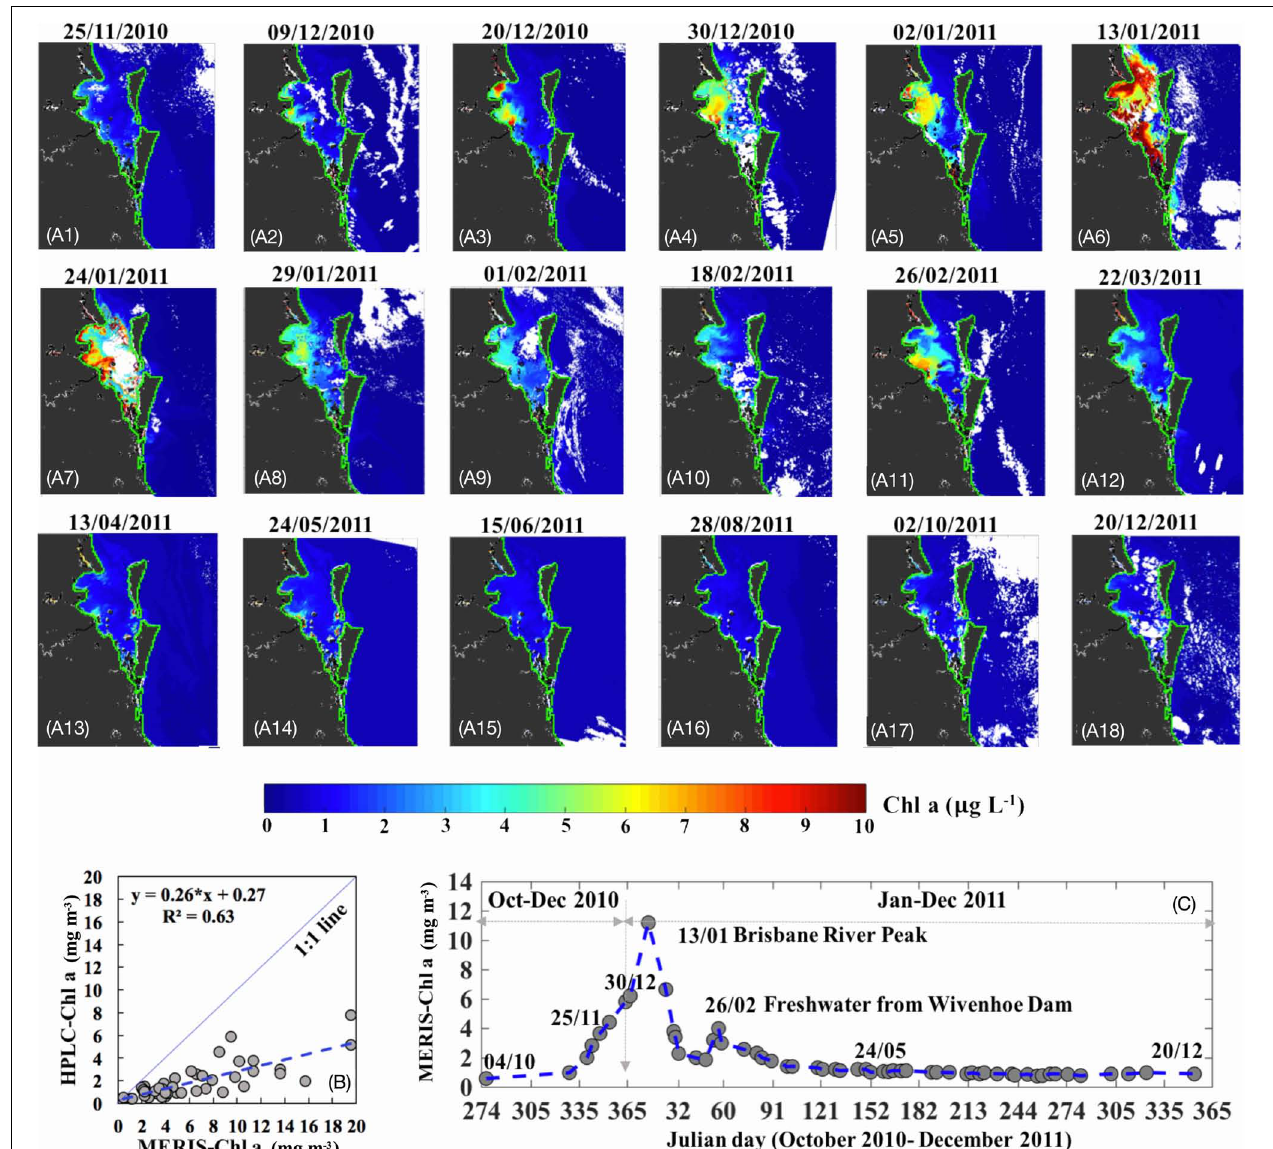
FIGURE 3 | (A 1 − 18 ) MERIS-derived Chl-a shown for the period of 25 November 2010 to 20 December 2011. (B) Relationship between MERIS neural network Chl-a (algal 2 product for Case 2 waters) and in situ HPLC-Chl-a used for obtaining the corrected MERIS Chl-a ( n = 46, p < 0.001). (C) Mean of Chl-a corresponding to locations of field sampling stations for ∼ 50 cloud-free MERIS images.